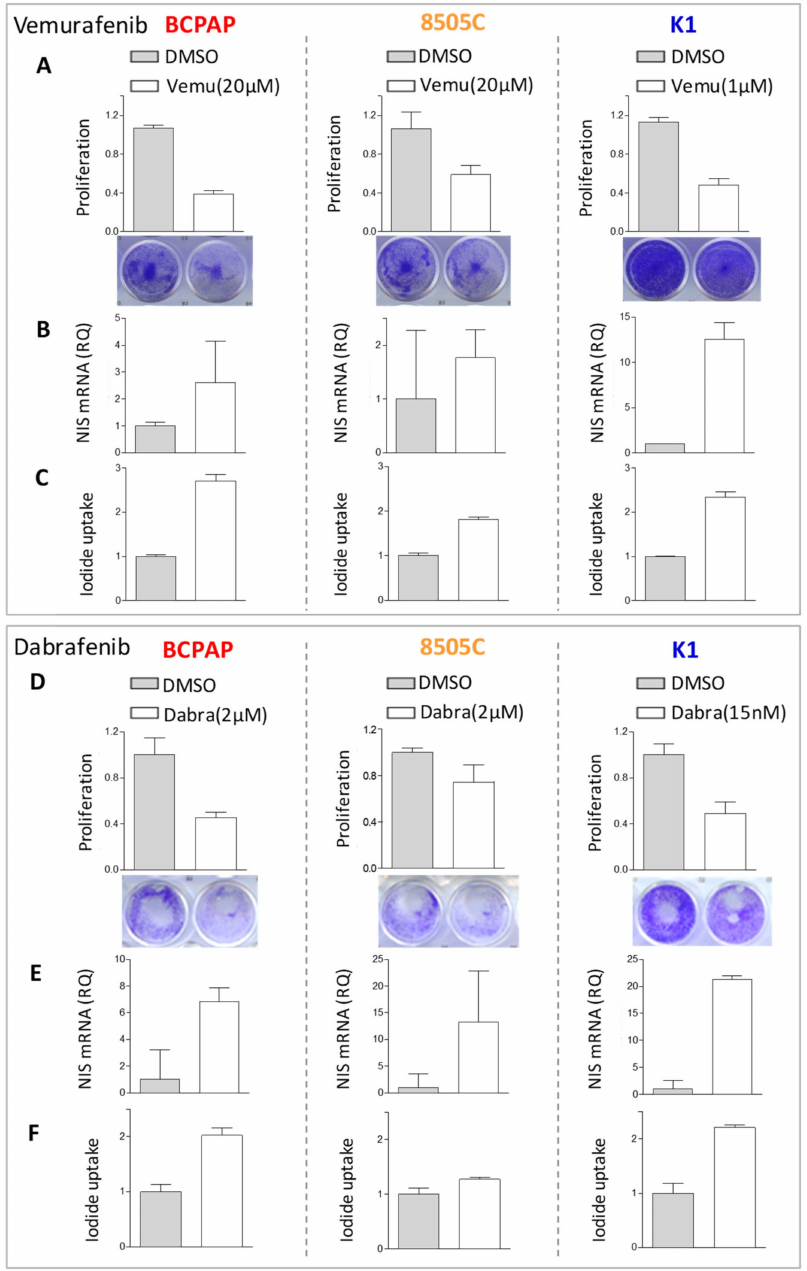
Figure 3. Iodide uptake capacity in thyroid cancer cells following BRAF inhibitors treatment. ( A , D ) Cell proliferation by crystal violet assay in DMSO and BRAF inhibitors treated cells; data are recorded as absorbance at 570 nm and are normalized to control cells treated with vehicle DMSO; mean ± SD of technical replicates. Below representative images of crystal violet stained cell culture plates. ( B,E ) NIS expression by quantitative RT-PCR in DMSO and BRAF inhibitors treated cells; data are reported as relative quantity normalized to HPRT gene used as endogenous control and are shown relative to DMSO treated control cells; mean ± SEM of three technical replicates. ( C , F ) Iodide uptake assay by Sandell–Kolthoff reaction, absorbance detected at 420 nm. Uptake value was normalized to the corresponding cell proliferation index reported above; data are reported relative to the DMSO treated control cells as mean ± SD of technical replicates. All assessments were performed at 48 h after BRAF inhibitors treatment. Abbreviations: DMSO, DMSO treated control cells; Vemu, Vemurafenib; Dabra,